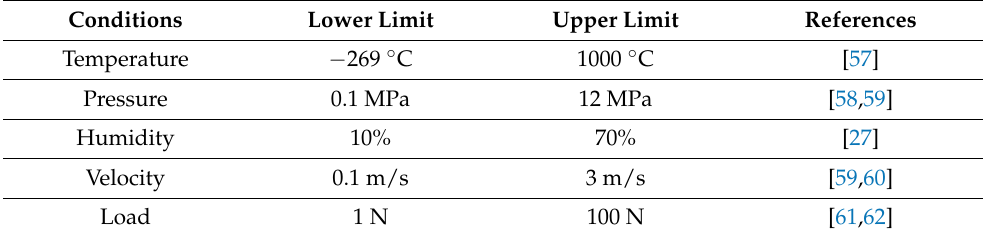
Figure 2. Typical solid lubricants. Table 1. The applied range of extreme conditions.